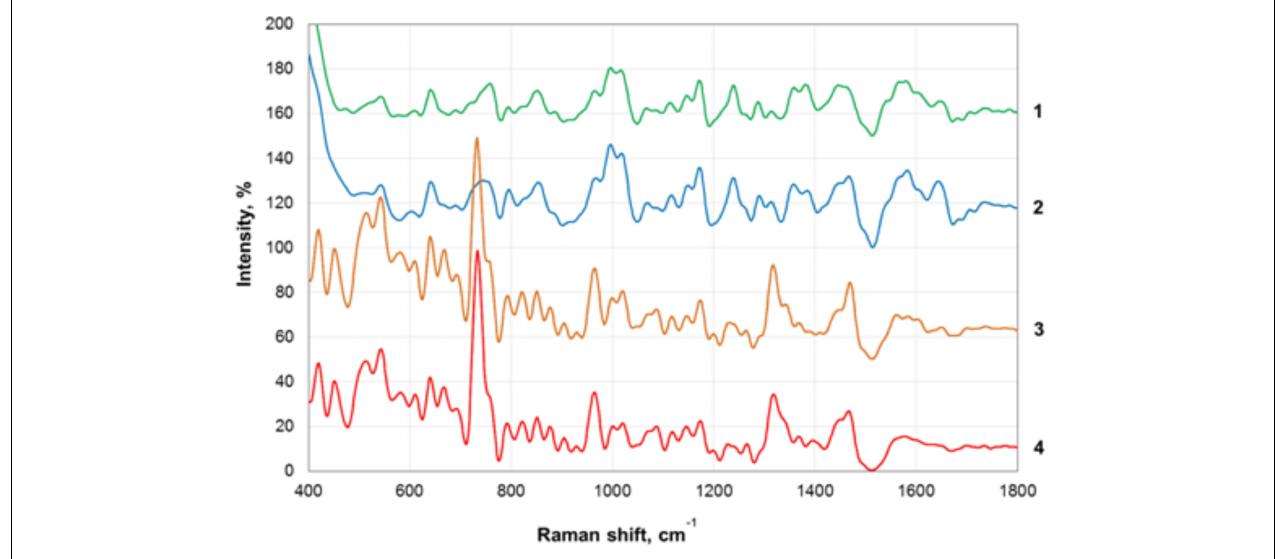
FIGURE 4 | Surface-enhanced Raman scattering (SERS) spectra of the biofilm biomass and biofilm matrix of C. acnes RT5. 1—Upper phase of the matrix; 2—lower phase of the matrix; 3—biomass after matrix removal; 4—biomass of untreated